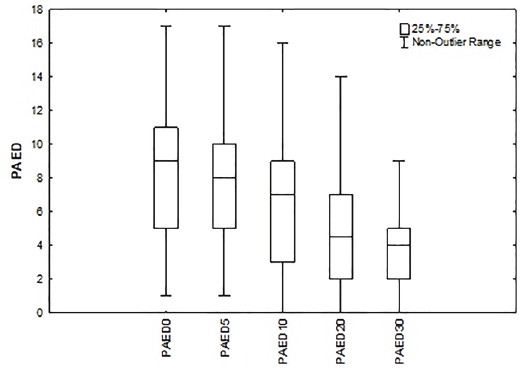
Figure 3a - PAED (0-30 min) score graph of group 1 Figure 3b - PAED (0-30 min) score graph of group 2